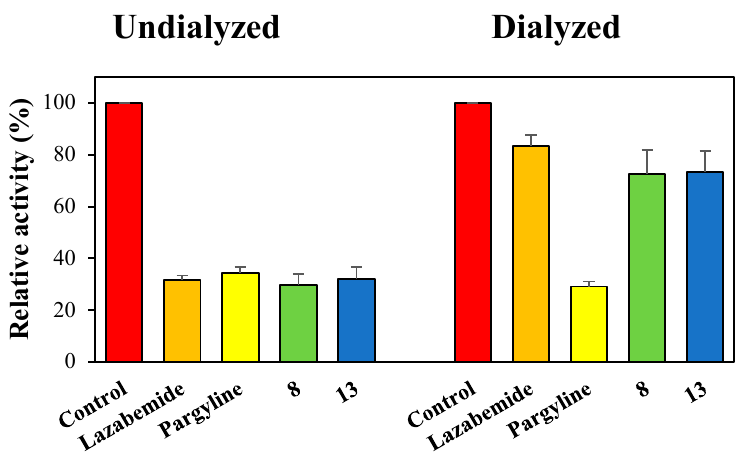
Figure 4. Recoveries of hMAO-B inhibitions by 8 and 13 after dialysis. Lazabemide and pargyline were used as reference reversible and irreversible MAO-B inhibitors, respectively. The concentrations of the inhibitors used were as follows: 8 and 13 , 0.90 and 1.44 µ M, respectively; lazabemide, 0.22 µ M; and pargyline, 0.28 µ M. Results are the averages of experiments performed in duplicate.